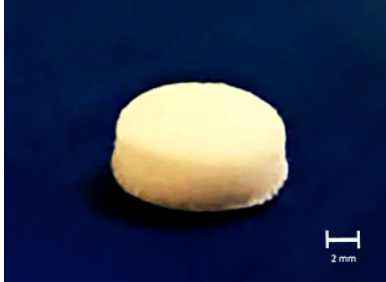
Figure 1. Freeze-dried matrix.